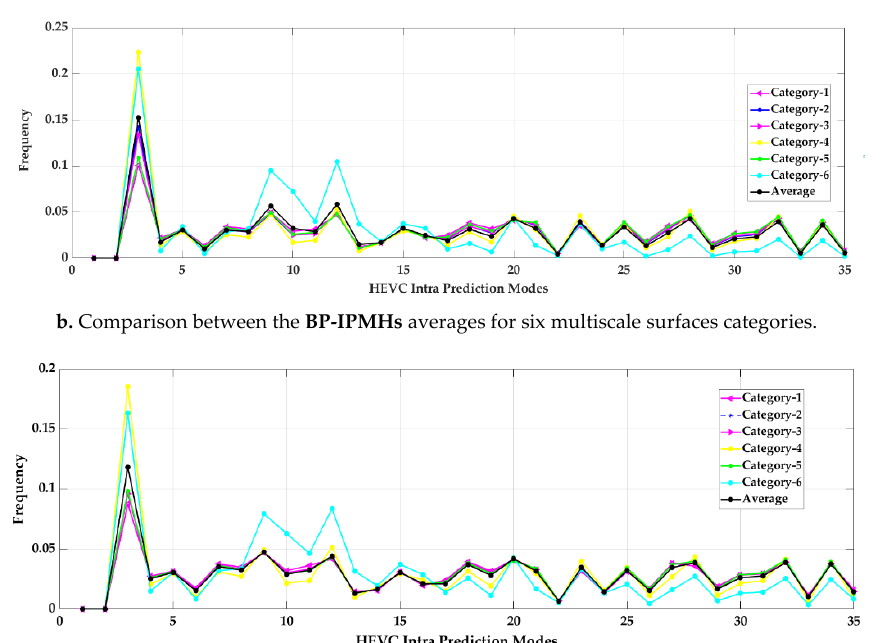
Figure 18. Illustrative example of HEVC intra-prediction efficiency for characterizing topographical image: ( a ) original image of 1024 × 1024 pixels; ( b ) selected modes to predict the original image (each prediction mode is represented here by one among 35 different colors); ( c ) intra-predicted image; and ( d ) the residual image (an anamorphic transformation is done on the whole gray scale to see morphological details).